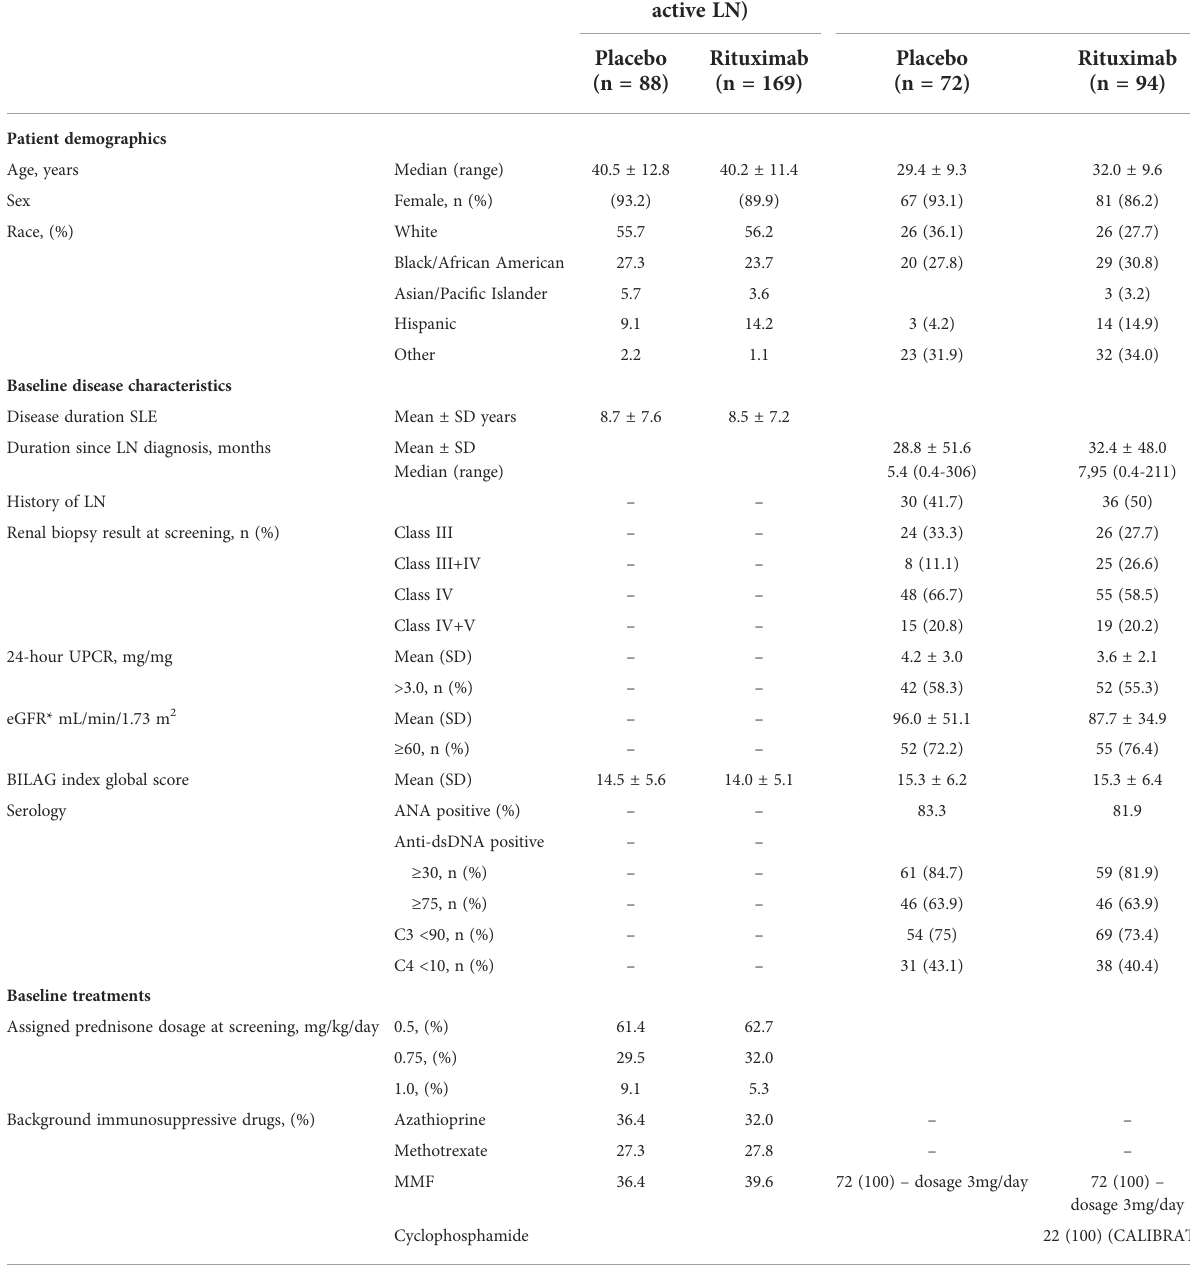
TABLE 3 Patient demographics and baseline/disease characteristics from EXPLORER, LUNAR, and CALIBRATE clinical